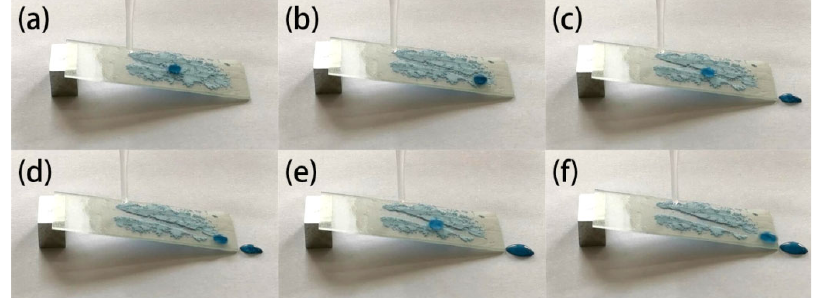
Figure 9. ( a – f ) Self ‐ cleaning test.